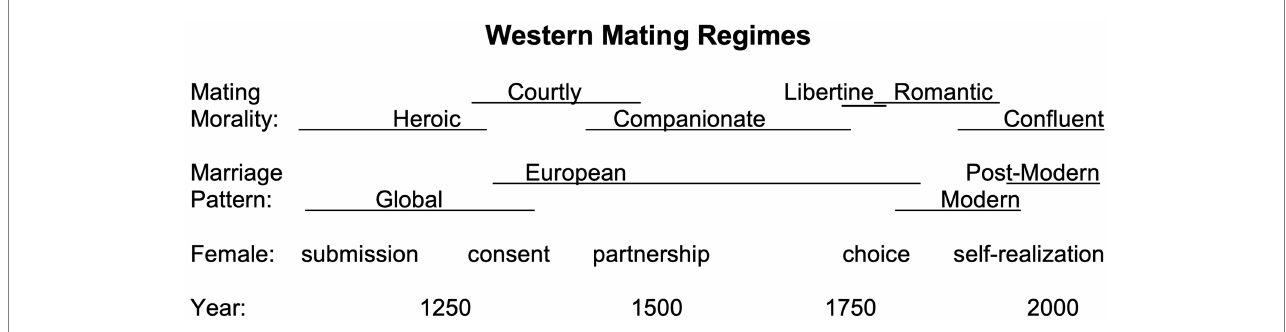
FIGURE 1 Changes in mating culture after Church MFPs dissolved Europe’s polygynous kinship societies. In this figure, I synthesize the works of Bandlien (2005), Boase (1977), Giddens (1992), Henrich (2020), Posner (1994), and Singer (1984, 1987). Copyright © 2022 by American Psychological Association. Reproduced and adapted with permission. Years correspond to transitions in the Nordic region. Each consecutive ideology empowered women as individuals. Heroic love: A woman should submit to the greater warrior. Courtly love: A man should earn a woman’s consent through chivalrous behavior and reciprocal passion. Companionate love: People should pair-bond informed by pragmatic concern. Libertine love: Pleasure-seeking through uncommitted copulation. Romantic love: Individuals should follow their emotions and merge with their mate. Confluent love: A pair-bond should last for as long as both parties benefit emotionally and/or materially. Global marriage pattern: A man around 30 years old marries a woman around 20, or both are around 20 and move in with his parents. European marriage pattern: After a period of skill and resource accumulation, a woman around 25+ establishes a new household with a slightly older man. Modern marriage pattern: Based on emotion and individual choice, with increasing rates of marriage as well as premarital sex. Postmodern marriage pattern: Low marriage rate, frequent divorce, serial monogamy, high singledom and promiscuity, and declining fertility.